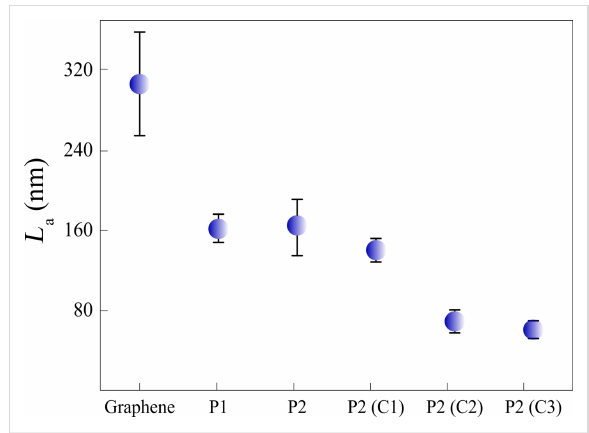
Figure 4: Size of well-ordered domains ( L a ) for CVD graphene (as- received), for graphene devices fabricated by procedures P1 and P2, and for graphene devices fabricated by procedure P2 and further cleaned by NMP (C1), DMF (C2), H 2 /Ar annealing (C3).